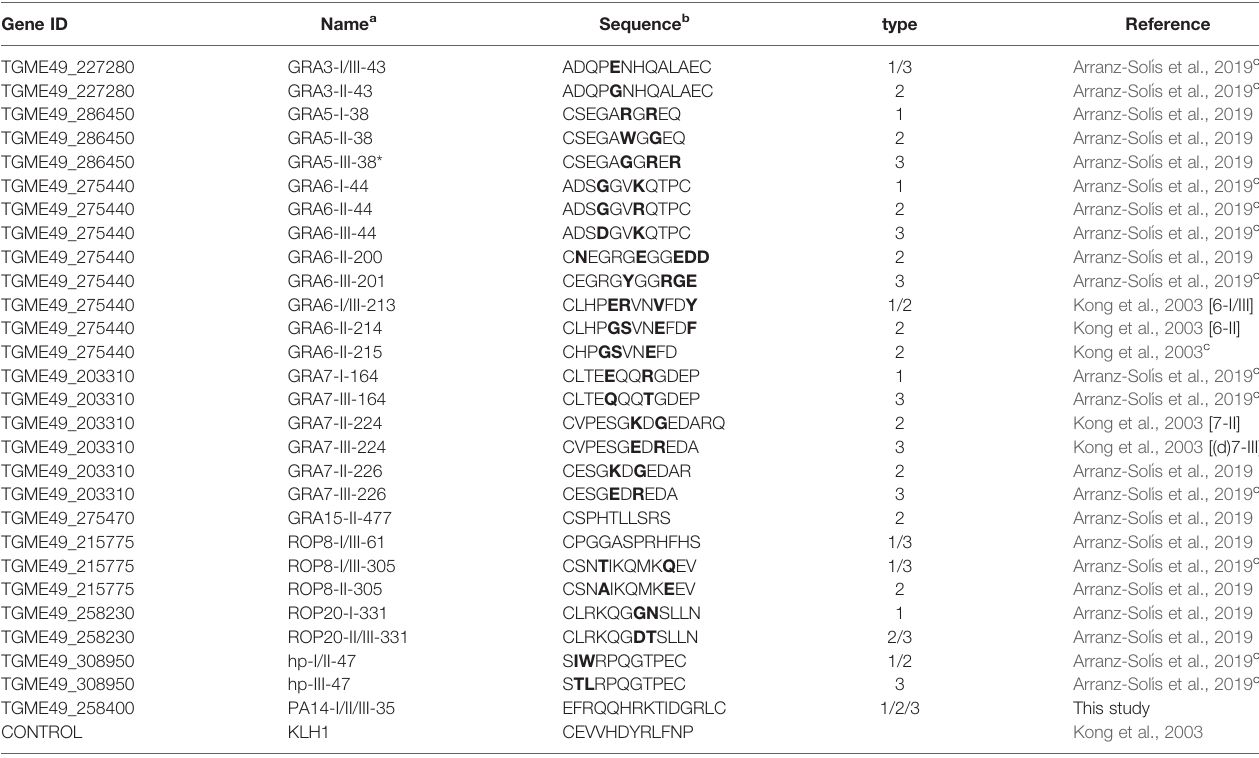
TABLE 1 | List of peptides used in the ELISA